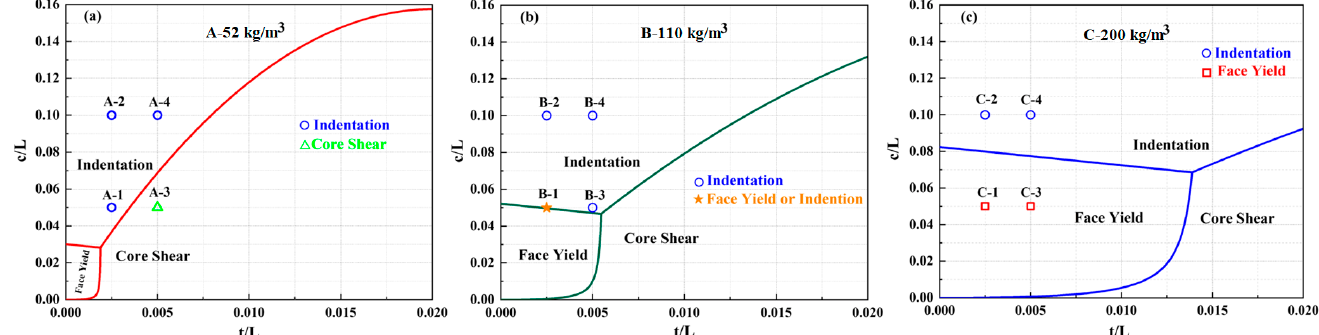
15 of 19 Figure 12. Typical failure modes of the three-point bending tests: ( a ) indentation failure mode of A- 0.5/10/0.5; ( b ) typical tensile failure mode of C-0.5/10/0.5. Figure 13 presents a comparison of the predicted failure-mode maps with the quasi- static results. The region of the face yield is expanded, while the region of the indentation and core shear shrink when the core density is increased, as depicted in Figure 13a–c. Specimen A3-1.0/10/1.0 collapsed in an indentation mode, not a core shear mode, as pre- dicted theoretically in Figure 13a. However, all specimens with a core of 110 kg/m 3 in density are located in the region of the indentation mode, which indicates that the theo- retical prediction is a good agreement with the quasi-static experimental results, as shown in Figure 13b and listed in Table 2. While specimens C2-0.5/20/0.5 and C3-1.0/10/1.0 were deformed in the test and experienced tensile failure, the indentation modes were not de-